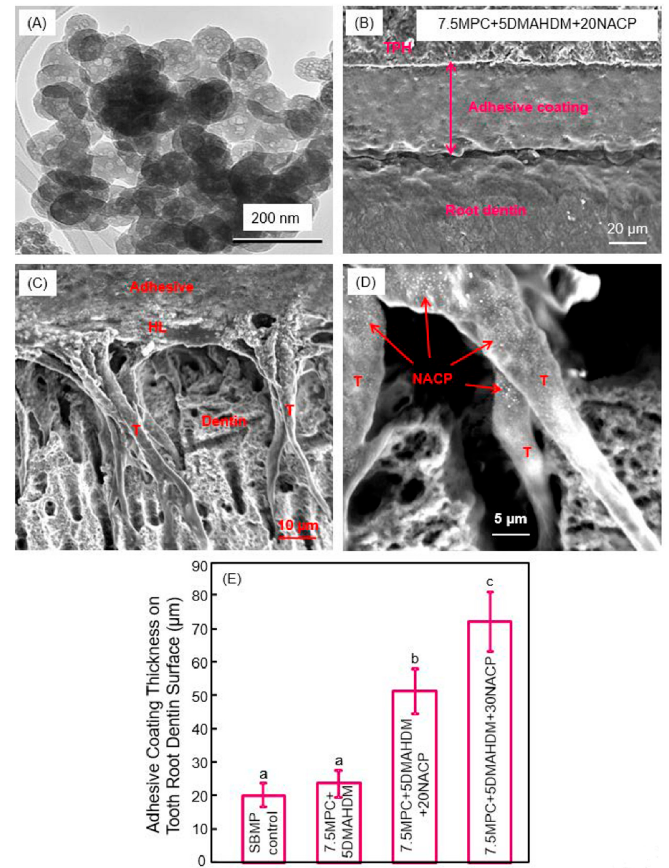
Figure 6. Nanoparticles of amorphous calcium phosphate (NACP) in protein-repellent and antibacterial tooth root coatings. ( A ) SEM image of NACP. ( B ) SEM image of tooth root coating. ( C ) Hybrid layer (HL) and resin tags (T). ( D ) NACP flowed with adhesive into dentinal tubules. ( E ) Incorporation of NACP increased the coating thickness to protect tooth roots (mean ± SD; n = 6). Dissimilar letters indicate values that are significantly different from each other ( p < 0.05). (Reproduced with permission from [90]. Elsevier,